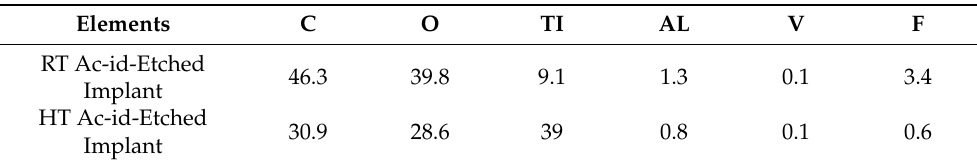
Table 3. Elemental composition (in %/) of the implant surface after RT and HT acid etching treatment as evaluated by XPS